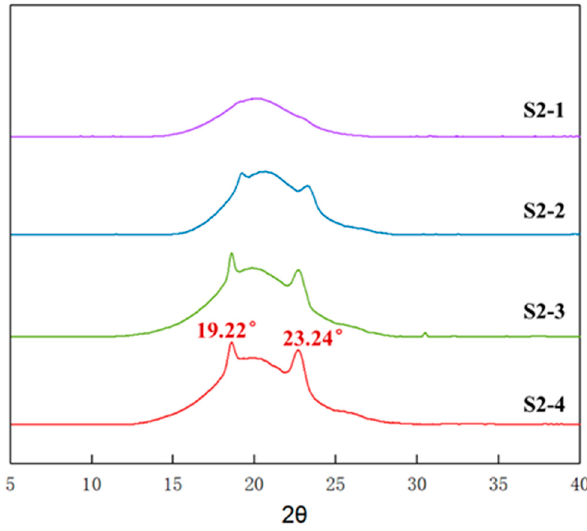
Figure 7. WAXD spectra of elastomers with different PEG contents.